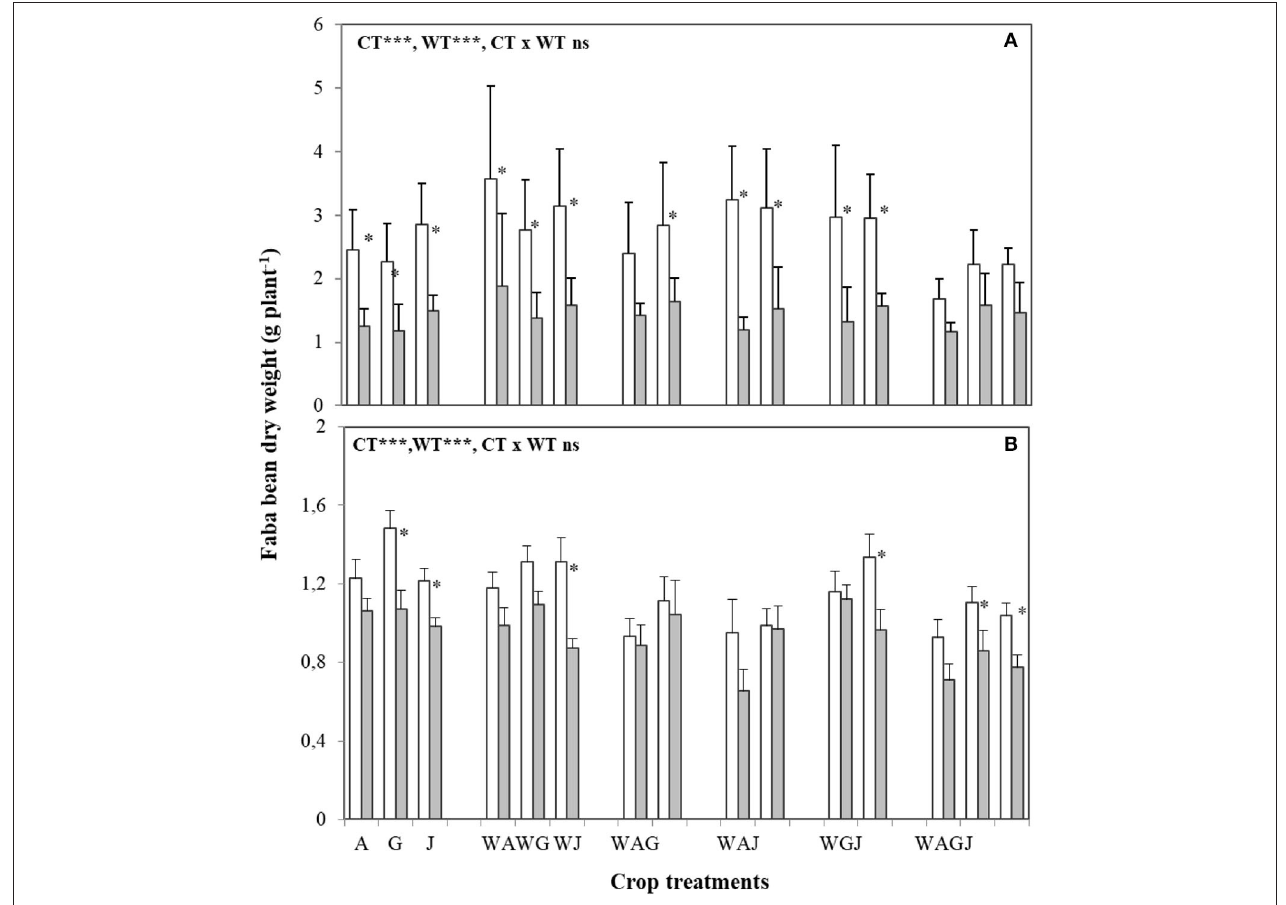
FIGURE 2 | Dry weight of shoot (A) and root (B) of the three faba bean varieties A, G, and J grown as sole crops (A, G, and J) or intercropped with wheat (W) under adequate watering (80% field capacity; open bars) vs. water-stressed (30% field capacity, filled bars) conditions. Data are means and SE of six replicates harvested at 49 days post-transplantation. An asterisk * denotes a significant difference at p < 0.05.